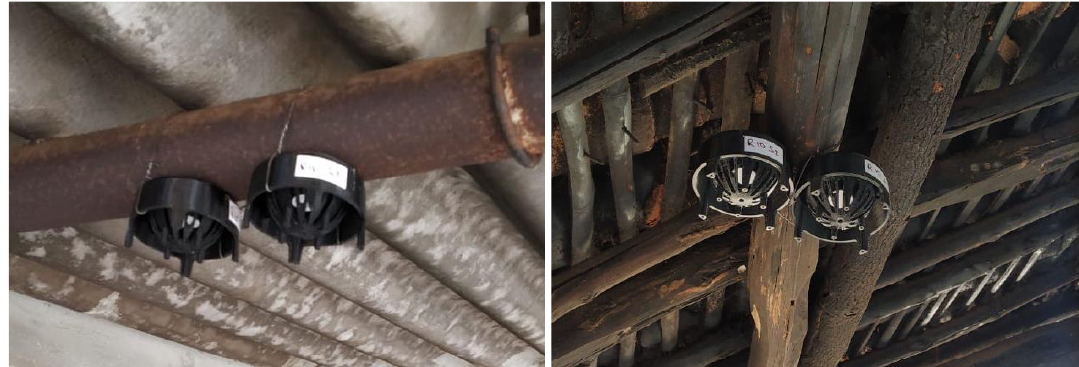
Figure A5. Deployment of paired low-cost passive samplers side-by-side in two indoor locations hanging from ( left ) a metal ceiling and ( right ) a wood ceiling.